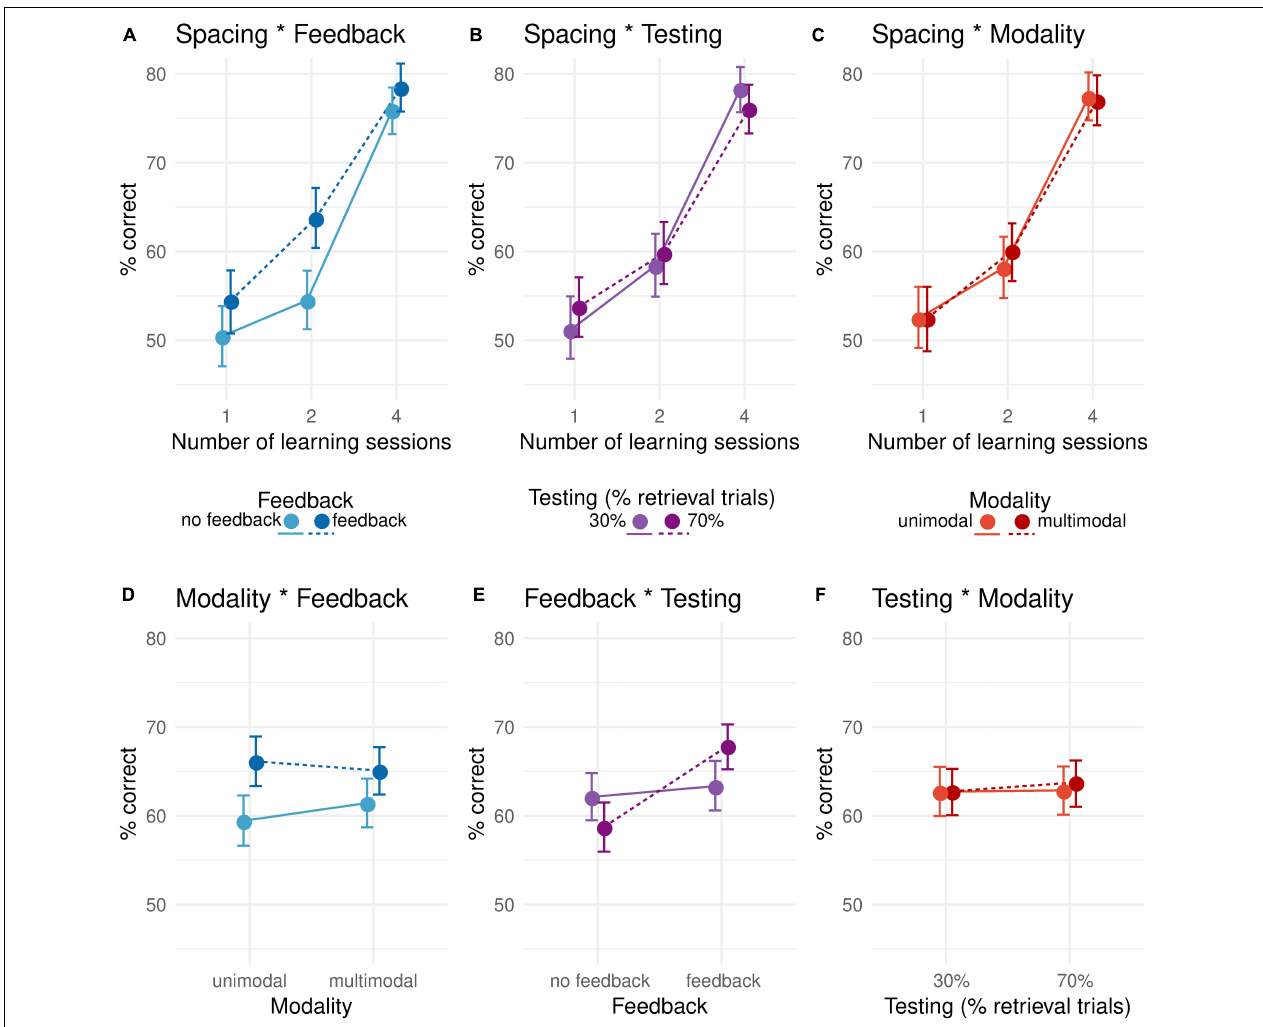
FIGURE 4 | Pairwise interaction plots between learning principles. (A–C) Interactions with between-subjects factor Spacing. (D–F) Interactions between the three within-subjects factors Feedback, Testing, and Modality. Values are offset horizontally to avoid over-plotting of error bars. Error bars indicate non-parametrically bootstrapped 95% confidence